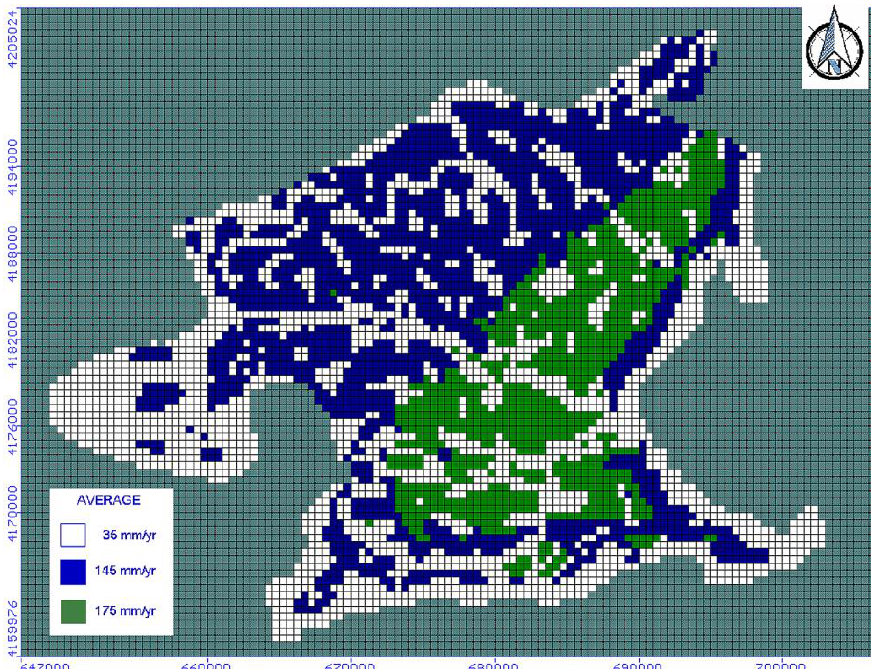
Figure 6. Spatial distribution of recharge.